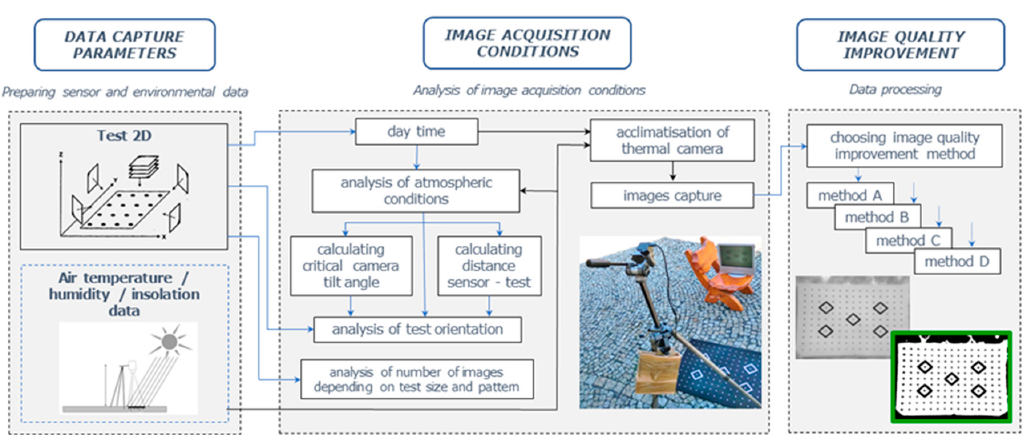
Figure 9. Methodology of selection of appropriate parameters for obtaining 2D test images for UAV thermal cameras.